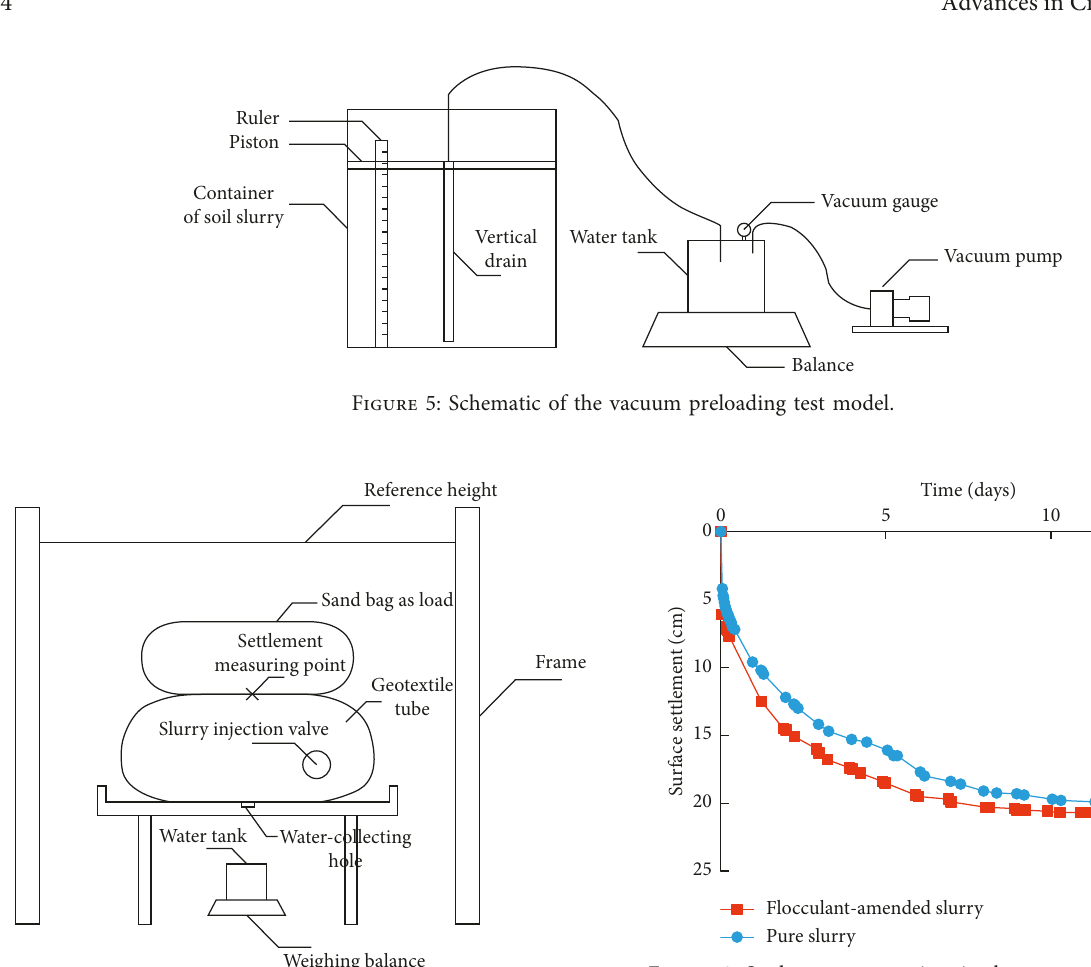
Figure 8: Settlement versus time in the vacuum preloading